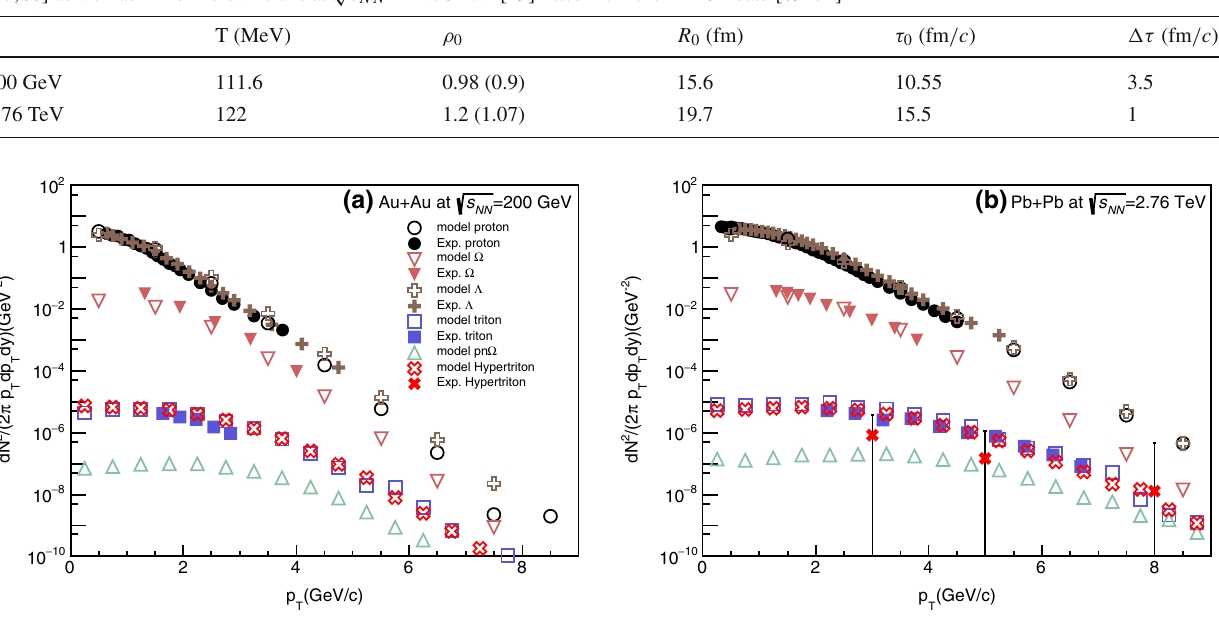
fit to the experiments, and the open makers for triton, hypertriton and (cid:3) pn are the results of BLWC model. Full makers are the data from the RHIC [67,72,73] and ALICE [69–71,74]